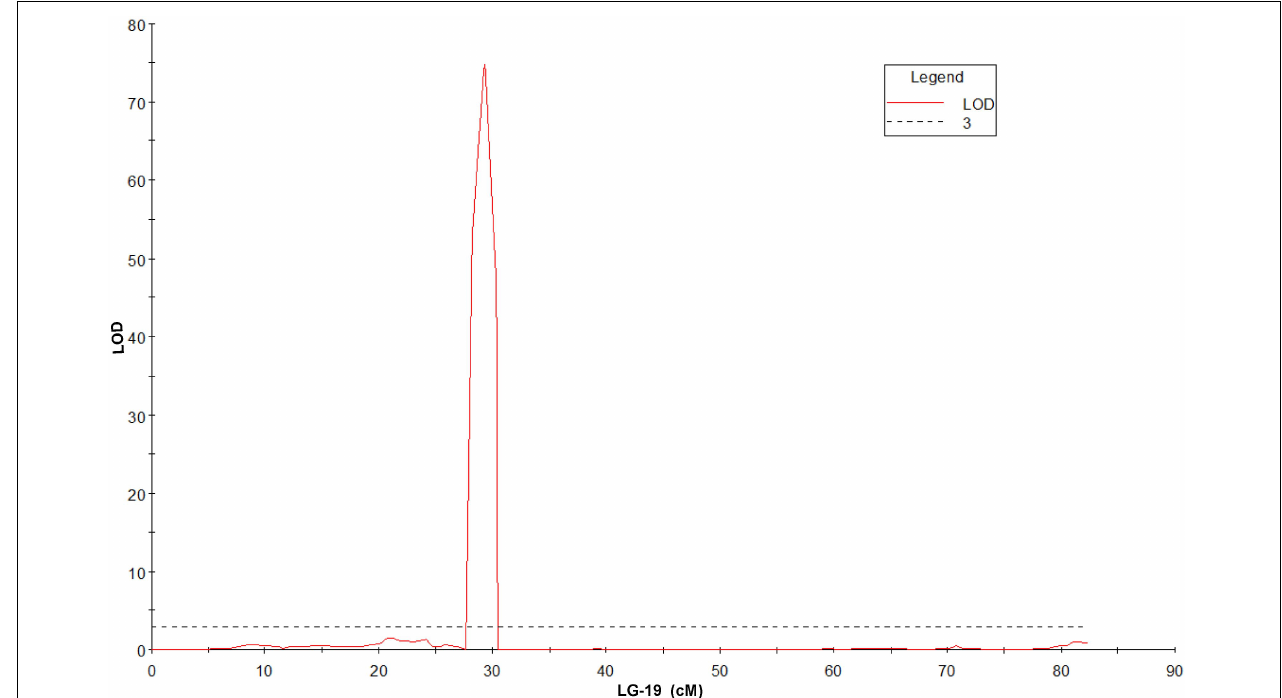
FIGURE 3 | QTL for gray leaf spot disease resistance on LG-19 in narrow-leafed lupin (LOD =